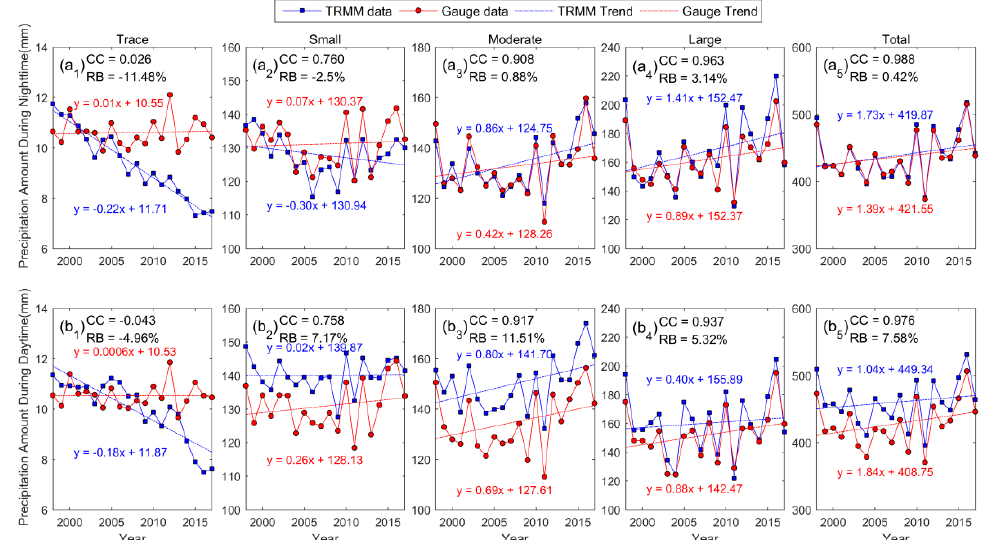
Figure 4. As in Figure 2, but for the amount of precipitation. The y -axis scales are different for different precipitation